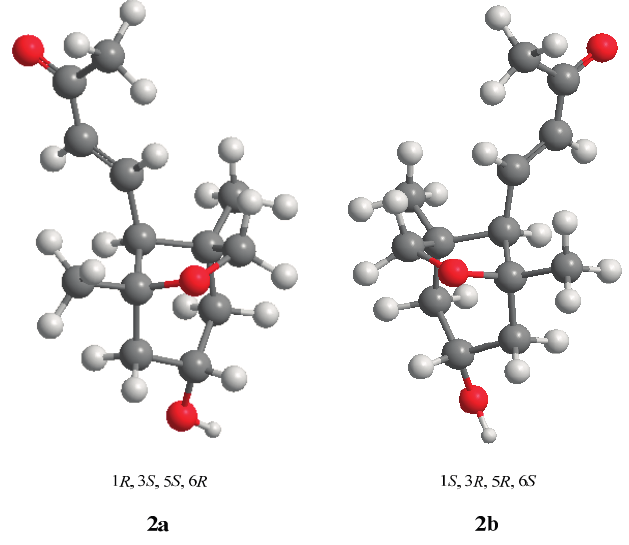
Figure 2. Significant HMBC and NOESY correlations of compounds 2a and 7 .